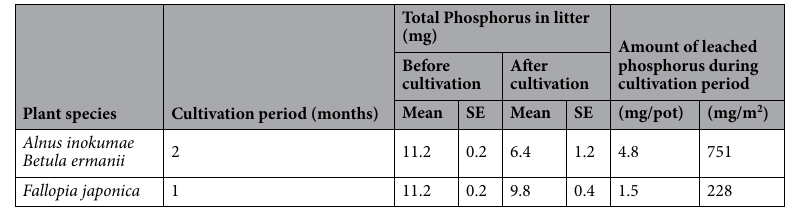
Figure 2. Effect of litter on the growth of Fallopia japonica ( n = 11–12), Alnus inokumae ( n = 5–6), and Betula ermanii ( n = 5–6). ( a ) Differences in growth with and without litter. ( b ) Differences in growth with nutrition. ( c ) Verification of growth-promoting nutrition supplied by litter. ( d ) Differences in total phosphorus ( n = 5–6) and nitrogen ( n = 3) of A. inokumae and B. ermanii before and after cultivation, and with or without litter addition. The raw data are available in Supplementary Table S2. The figure’s value are mean ± SE. Mann–Whitney U-test was used for ( a ). Kruskal–Wallis with post-hoc Steel–Dwass tests were used for ( b ), ( c ) and ( d ). p values are * p < 0.05, ** p < 0.01, *** p < 0.001. Growth of A. inokumae was promoted by phosphorus (P) or litter leaves (+). Growth of F. japonica and B. ermanii were promoted by both nitrogen and phosphorus (NP) and both nitrogen and litter leaves (N+). Litter leaves (+) increased phosphorus, especially in A. inokumae , and increased nitrogen levels in plants.